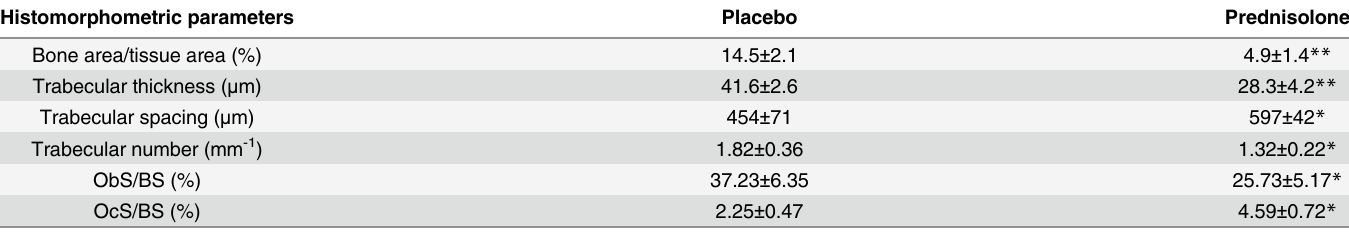
Table 2. Vertebral cancellous bone histomorphometry analysis in mice with and without 4-week prednisolone administration. ObS: Osteoblast sur- face, OcS: Osteoclast surface, BS: bone surface. Data shown are the mean ± SD. There are ten animals per group.